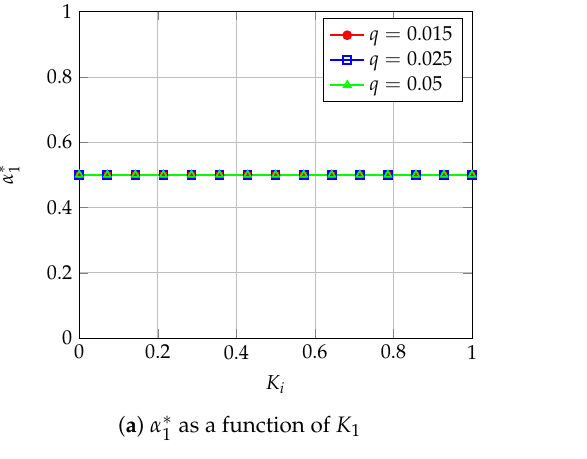
Figure 4. α ∗ and λ ∗ as a function of K i 1